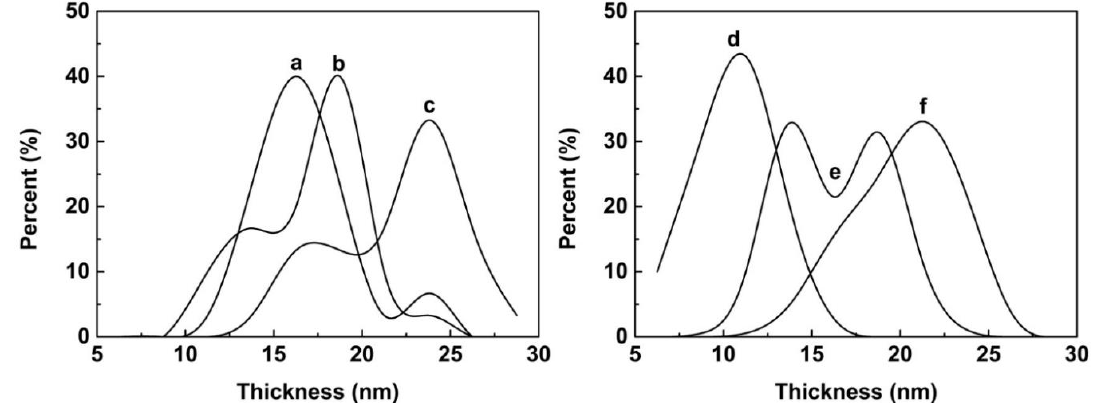
Figure 3. SEM images of the precursors: ( a ) A27H3, ( b ) A27H6, ( c ) A27H9, ( d ) A27W3, ( e ) A27W6, and ( f ) A27W9.